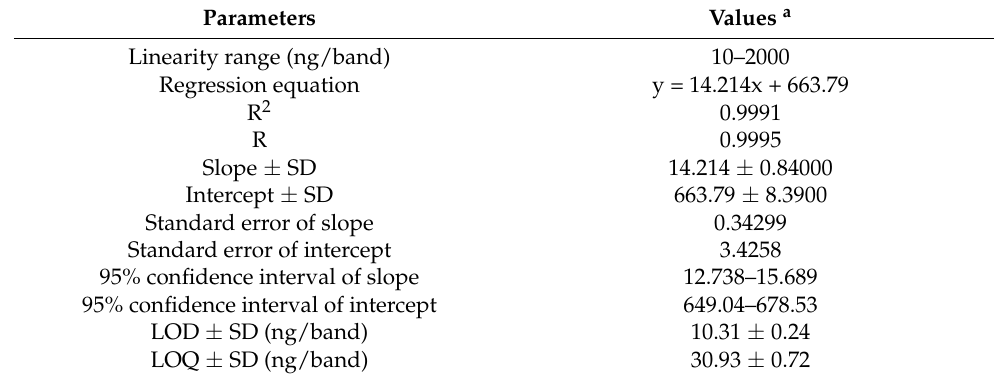
Table 1. Results of the linear regression analysis for the analysis of thymol using the greener HPTLC assay a